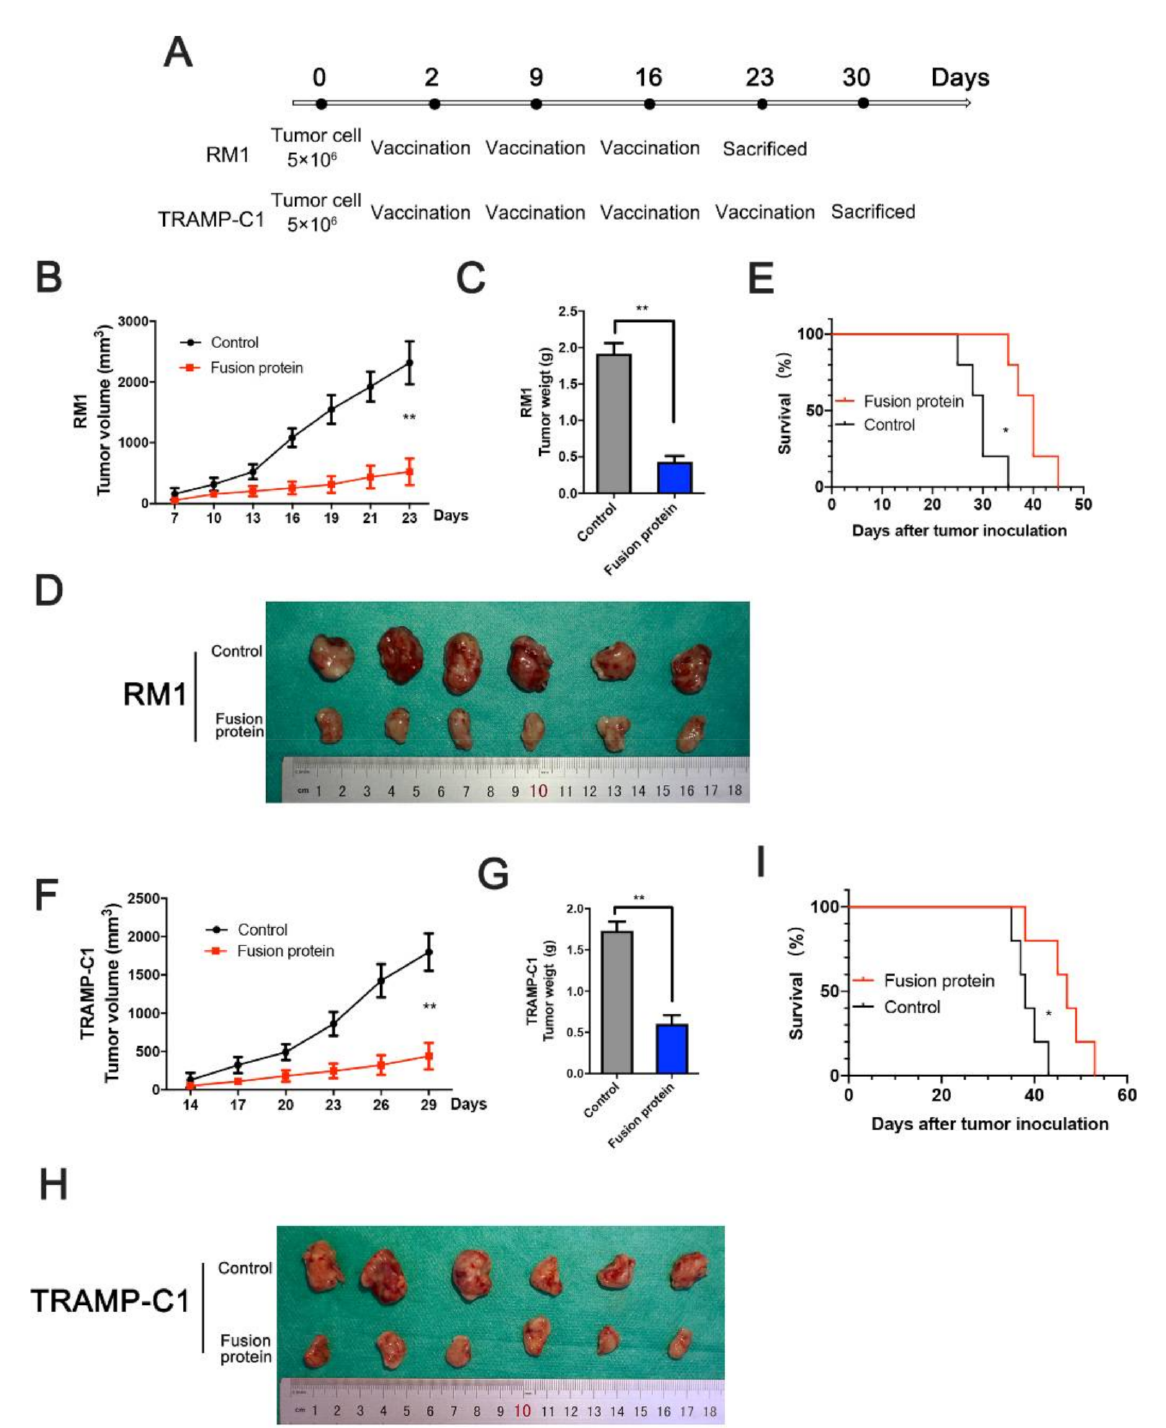
Figure 4. Immunization with fusion protein inhibited prostate cancer cells in mice. ( A ) Schematic diagram for the immunization and xenograft in MHC-matched C57BL6 mice. RM1 xenograft was immunized thrice, and TRAMP-C1 xenograft was immunized four times. ( B ) Tumor volume analysis for RM1 xenograft. ( C , D ) RM1 tumor weight measurement after the mice were sacrificed. ( E ) The Kaplan–Meier survival curves of RM1 model for different treatments. ( F – I ) Tumor growth analysis and TRAMP-C1 xenograft tumor in prophylactic settings. * p < 0.05; ** p <